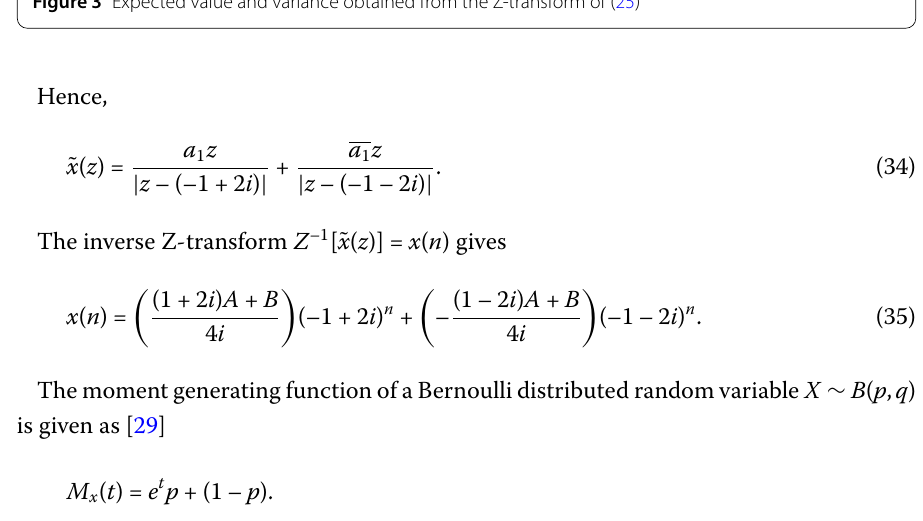
Figure 3 Expected value and variance obtained from the Z-transform of